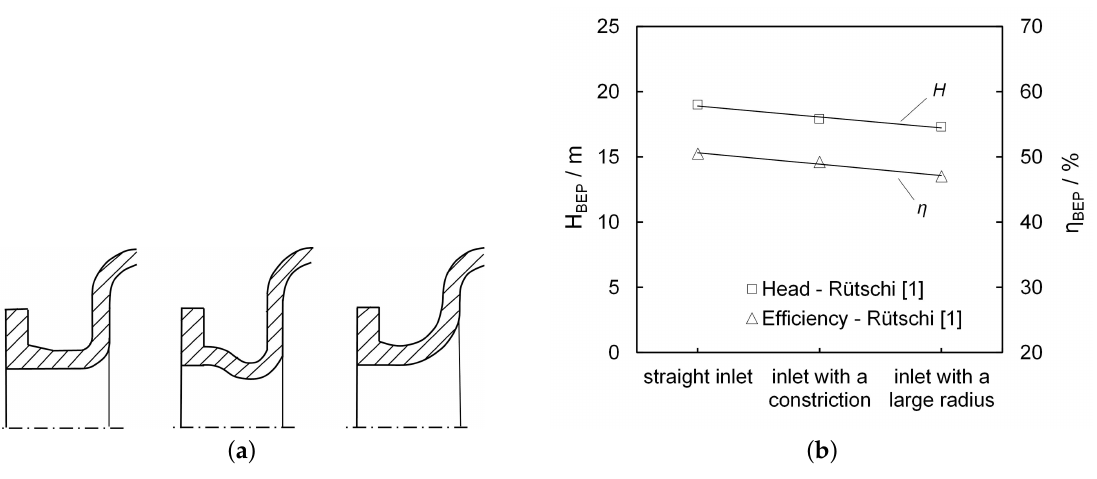
Figure 19. ( a ) Different inlet geometries of the suction pipes (based on [1]; from left): a straight inlet, an inlet with a constriction and an inlet with a large radius of curvature; and ( b ) influence of the suction pipe inlet geometry on the head and efficiency.